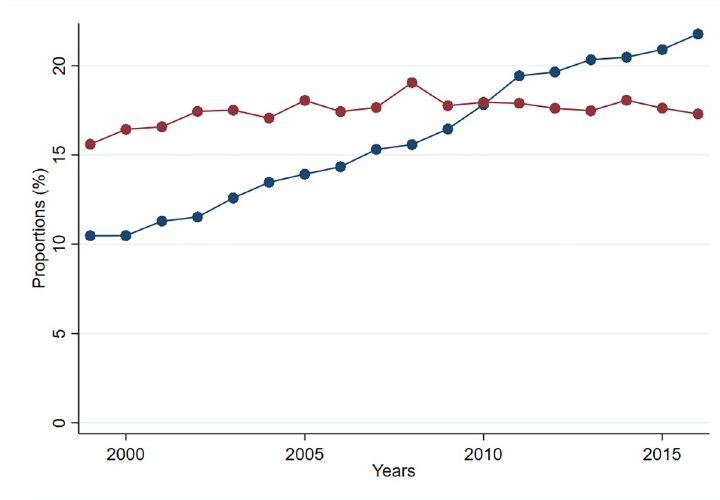
Fig 6. Proportion of induced labor and CS births among induced labors by year, 1999–2016. The blue line shows the proportion of births that were induced; the red line shows the proportion of CS in births that were induced. CS, cesarean